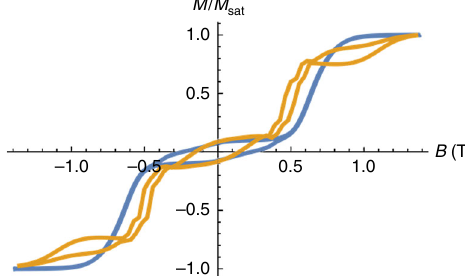
Fig. 9 Simulation of single-crystal magnetization. Single-crystal experimental magnetization (blue curve) measured at T = 0.03 K and a sweep rate of 0.1 T s − 1 for a magnetic fi eld oriented parallel to the triangle ’ s planes and along the easy axis ( y -axis in Fig. 6), superimposed on the simulated dynamical magnetization at the same temperature, sweep rate, and fi eld orientation, by solving Eq. (8) on the basis of 56 out of the 256 states obtained from our model and reported in Supplementary Fig. 8, for the following numerical values of the transition rates appearing in the equations: Γ Cr = 10 5 Hz/(cm − 1 ) 3 ≫ Γ 1 = 10 − 7 × Γ Cr > Γ 2 = 10 − 3 × Γ 1 , and γ Cr